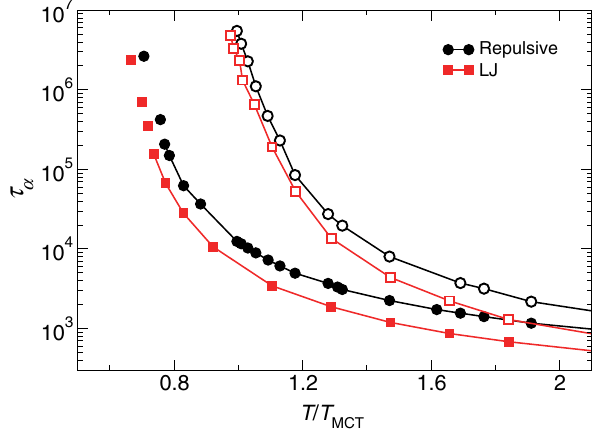
FIG. 15. Relaxation times for repulsive and Lennard-Jones potentials with a hybrid particle size distribution. Temperatures are scaled by T to allow direct comparison between models, MCT ¼ 0 . 680 and 0.543 for repulsive and LJ potentials, with T MCT respectively. Open symbols represent the standard Monte Carlo dynamics, closed symbols the swap algorithm, for which un- connected symbols represent structurally unstable state points where only a rough estimate of τ α is obtained in short